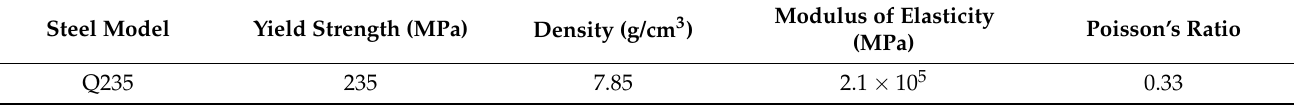
Table 6. Steel material parameters.